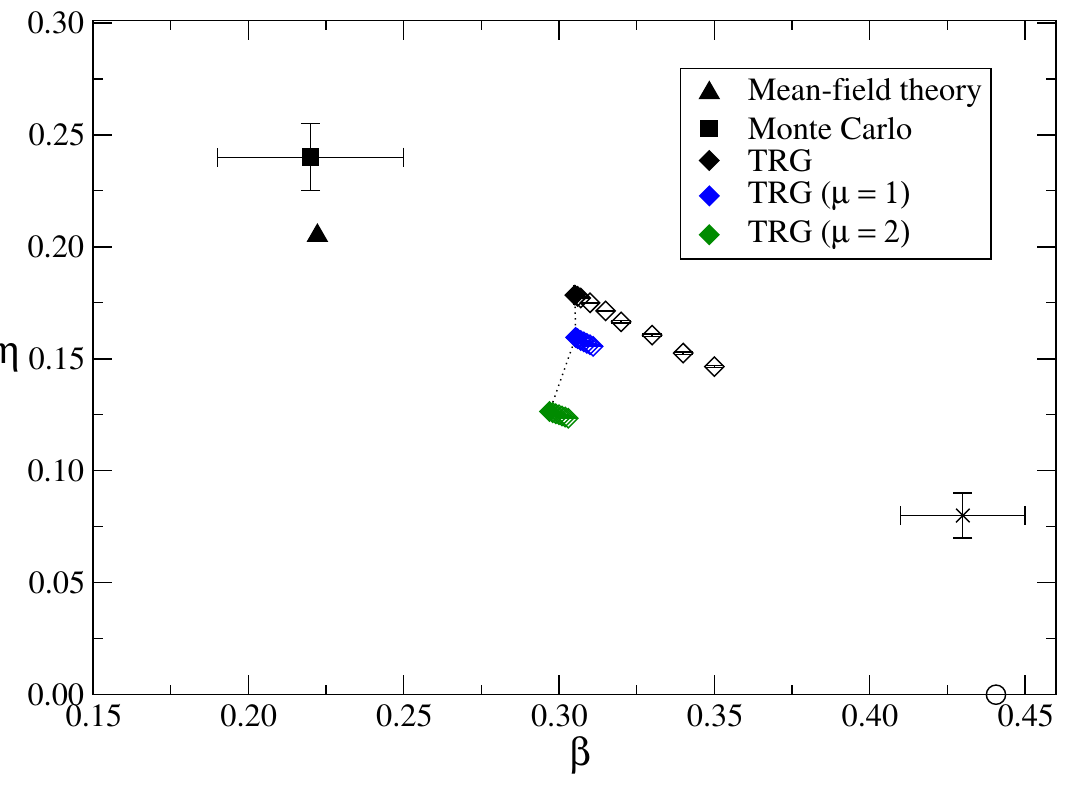
Figure 14 . Summary of the critical points obtained by several methods on the (3+1) d Z 2 gauge- Higgs model. The solid symbols correspond to the critical endpoints obtained by the mean-field theory [27] (triangle), the Monte Carlo simulation [28] (square), and the TRG method with D = 48 (diamond). All the dark symbols are located on the usual β - η plane with vanishing µ . Open diamonds show the first-order transition points located by the TRG method at each µ . Blue diamonds show the phase transitions between the confinement and the Higgs phases at µ = 1 and green ones correspond to those at µ = 2 . For reference, the triple point obtained by the Monte Carlo simulation [28] is represented by the star symbol. Also, the open circle on the β -axis is the first-order pure gauge transition derived in ref.